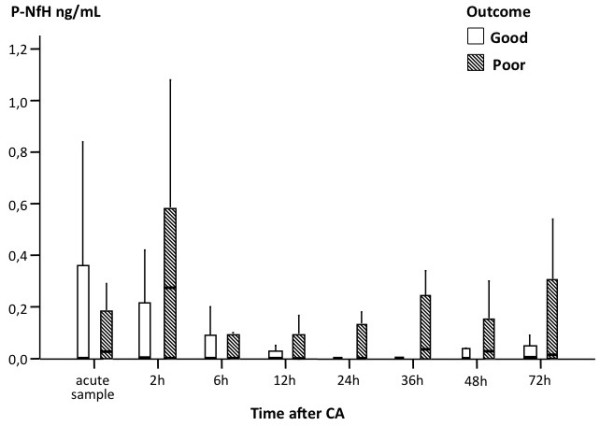
Box-plot comparing good and poor outcome groups of patients at the different sampling times. Boxes show the inter quartile range with median marked in the box, whiskers denote values within 1.5 times the interquartile range. Outliers are omitted. CA, cardiac arrest; NfH, neurofilament heavy chain.